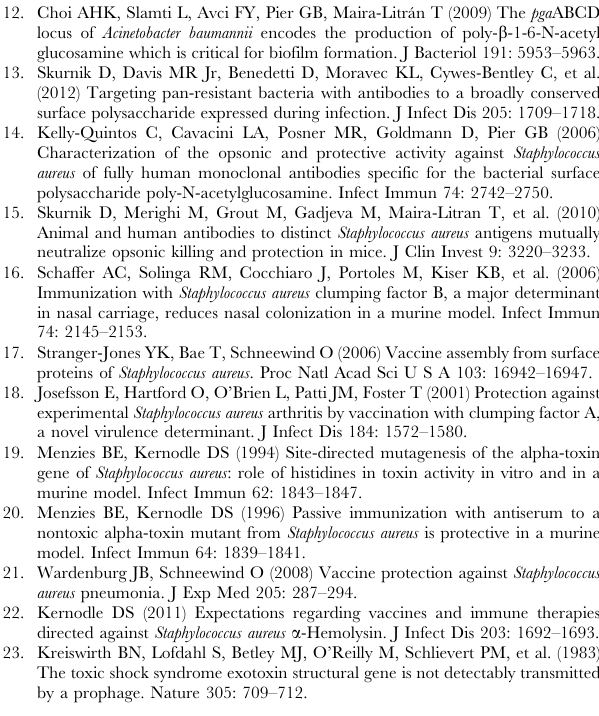
Figure S1 Purity of indicated recombinant protein used to produce conjugate vaccines. By analysis of the scanned gels all recombinant proteins were . 95% pure.